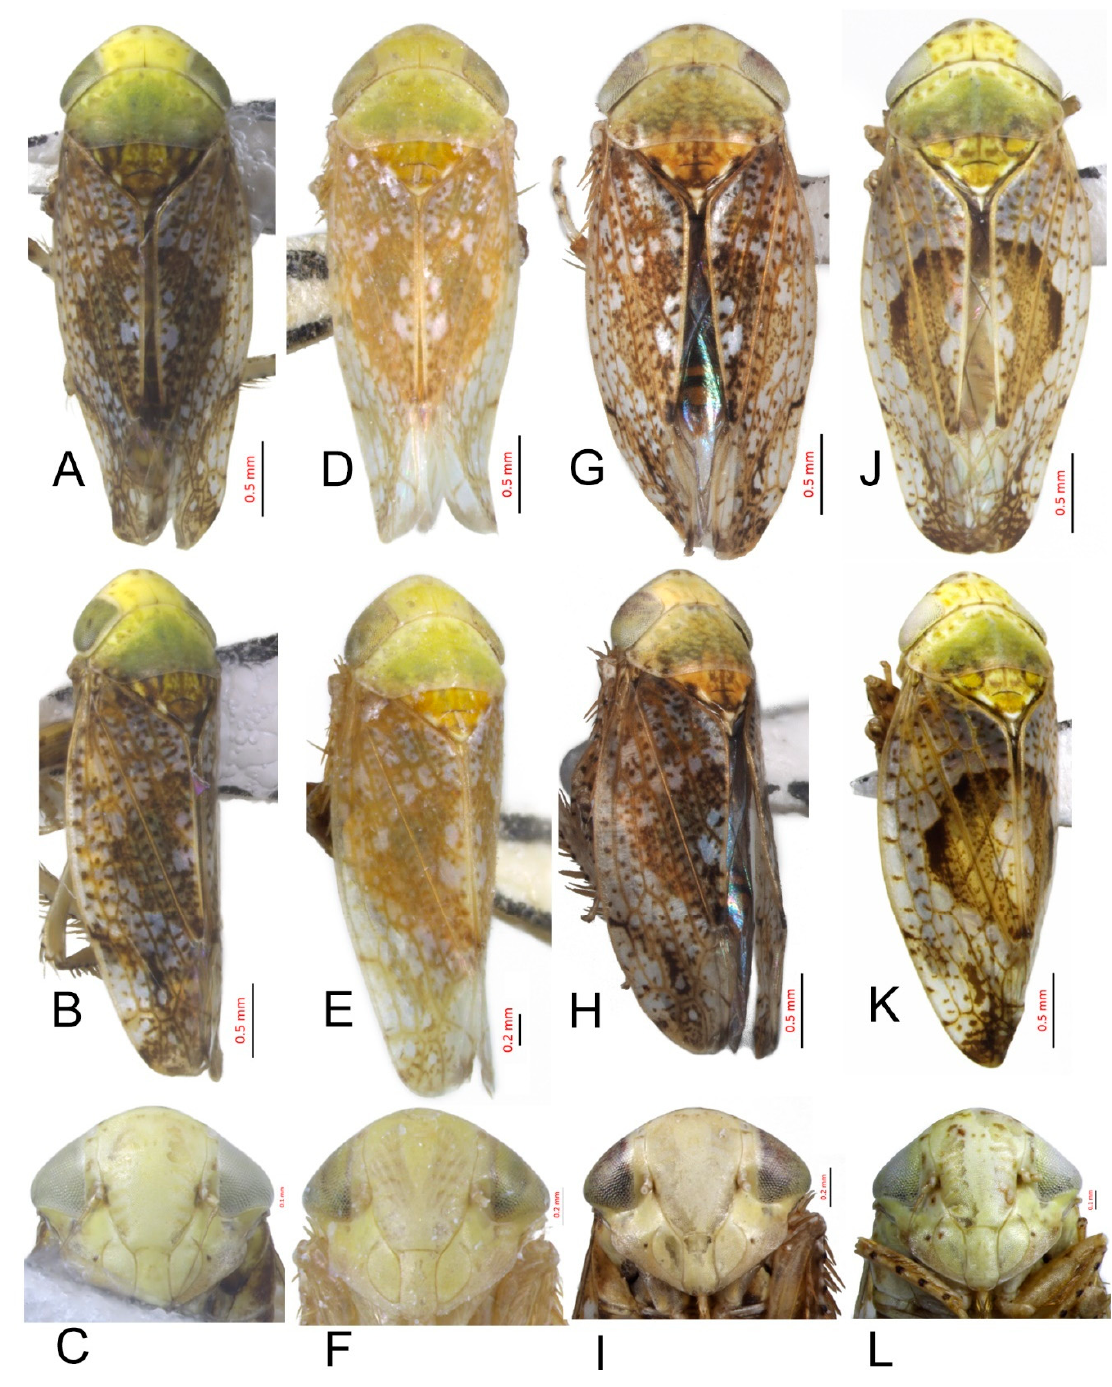
Figure 5. Species of Hishimonus . (A–C) H. phycitis ; (D–F) H. paraphycitis ; (G–I) H. viraktamathiellus ; and (J–L) H. triangulus . A, D, G, J. Dorsal view; B, E, H, K. latero-dorsal view; and C, F, I, L. Face.